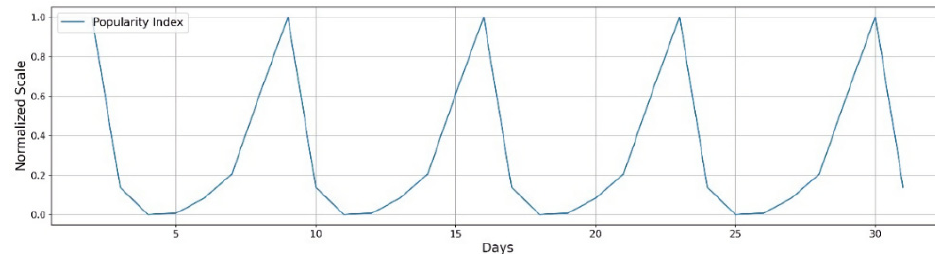
Figure 4. Popularity index changes in 30 days.